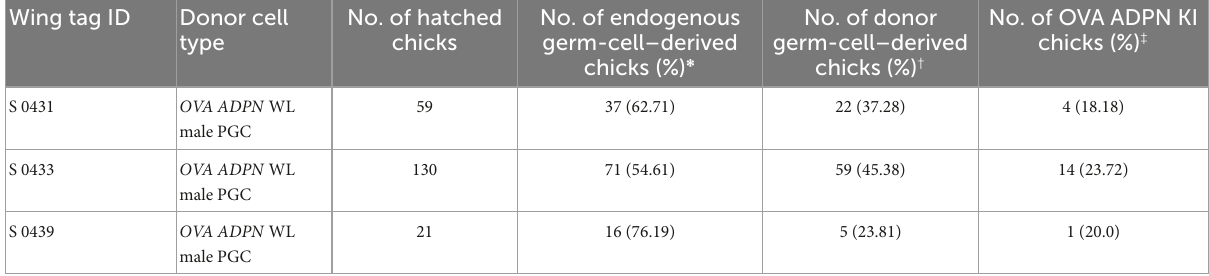
TABLE 1 Efficiency of germ-line transmission and genome-edited chick production of cOVA ADPN donor PGCs. Wing tag